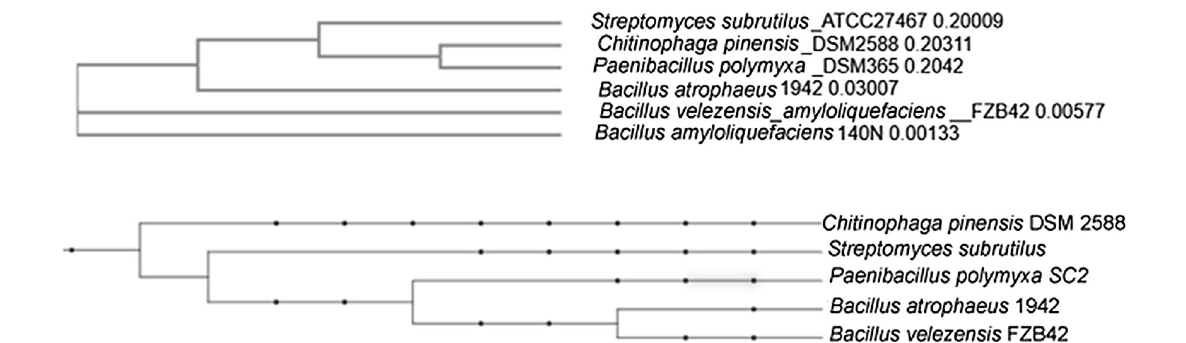
Fig. 7 Simple unrooted neighbor-joining phylogenic tree without correction, using the aminotransferase of known azasugar producers. Tree created through Clustal-Omega (https:// www. ebi. ac. uk/ Tools/ msa/ clust alo/). B. Phylogenetic tree created through PhyloT (https:// phylot. bioby te. de/) using NCBI taxonomy 16srRNA